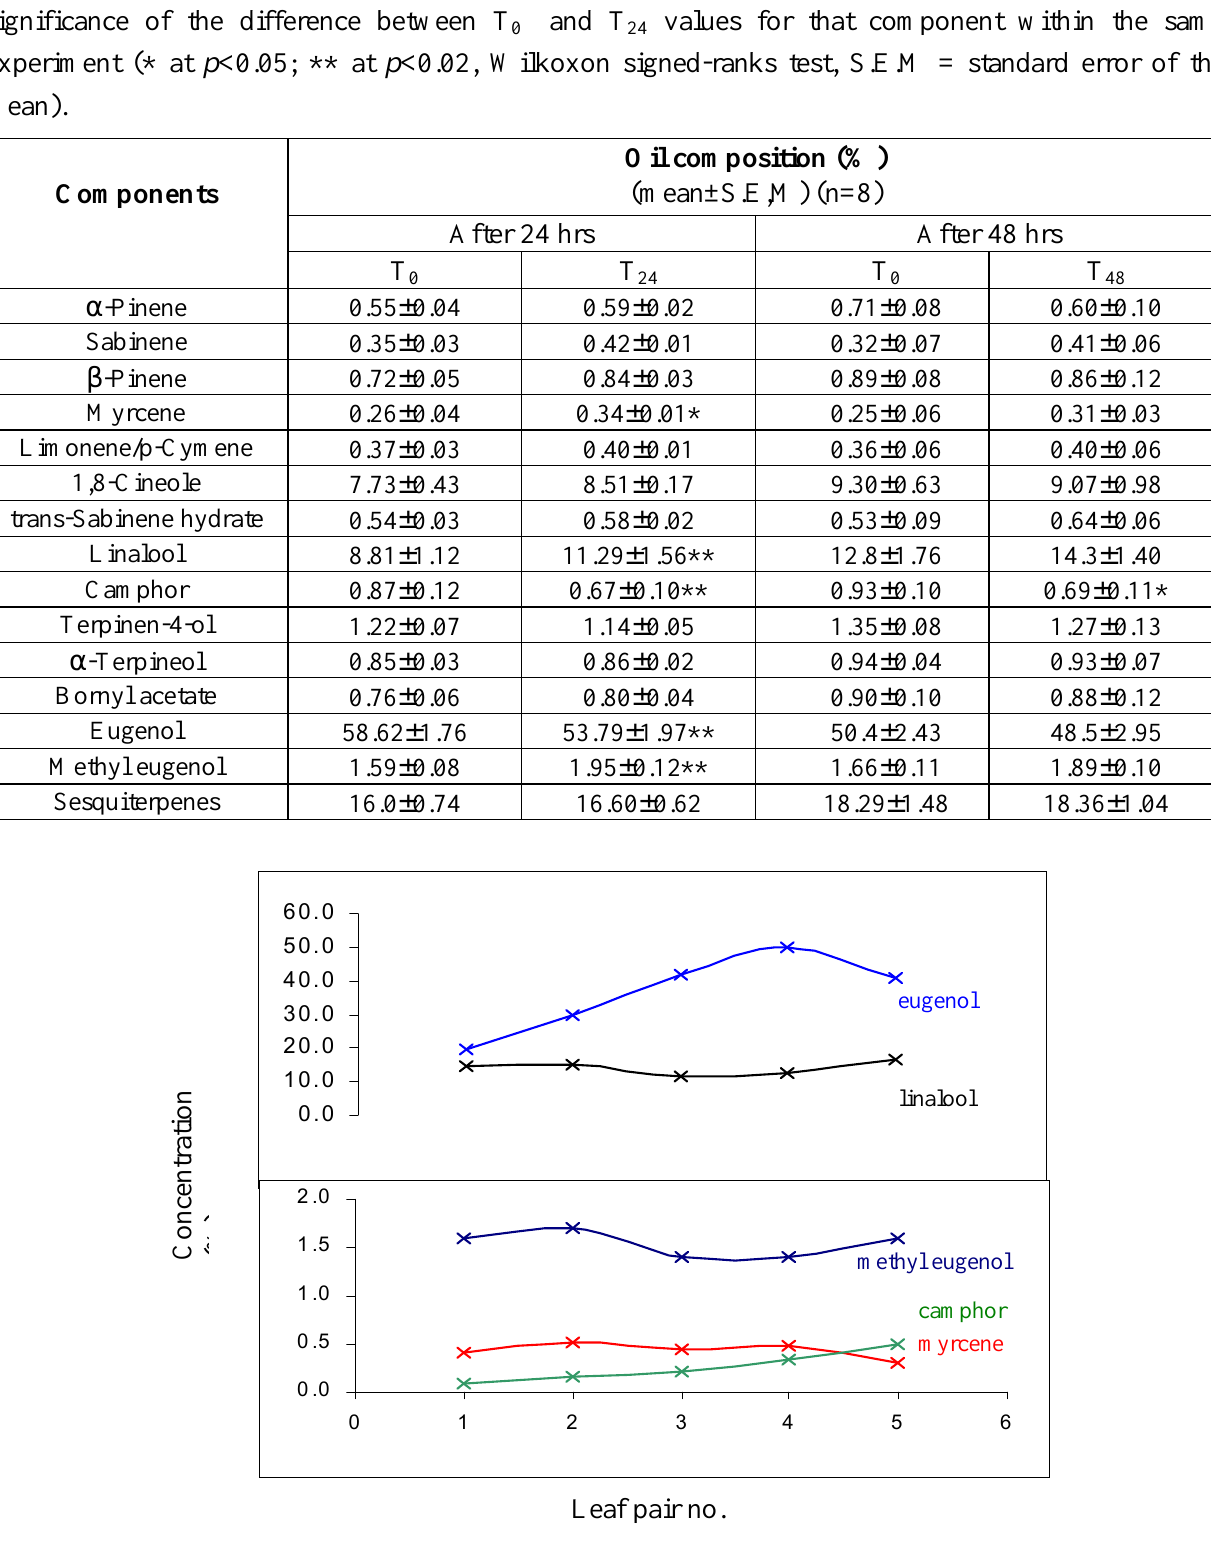
Figure 1. Ontogenetical variation in the levels of selected constituents found in the oil from O. minimum leaves. The compounds shown are those implicated in the wounding